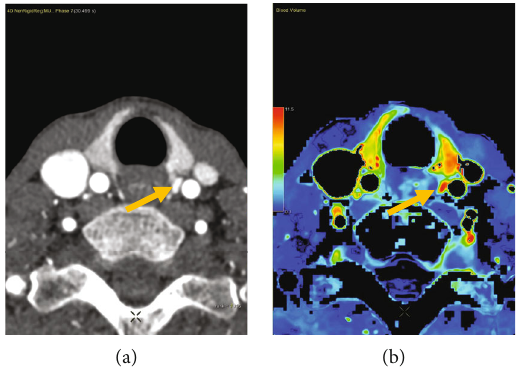
Figure 4: (a) 4DCT. On the arterial phase, we fi nd a small parathyroid adenoma (arrow) in close relation to the left common carotid artery. (b) Parametric perfusion map, color- coded overlay of BV values. Note the elevated BV in the parathyroid adenoma as compared to the thyroid tissue.